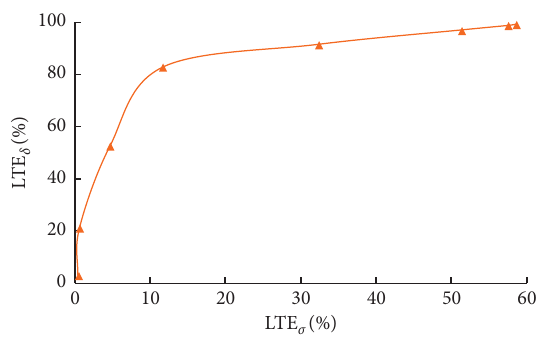
Figure 9: Relationship between LTE